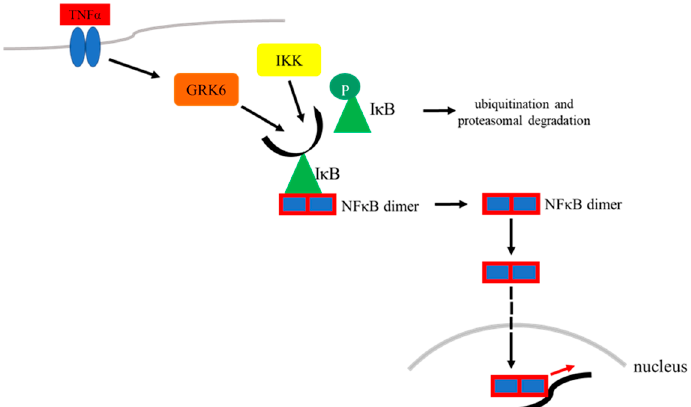
Figure 4. Influence of TNF ‐α induced activation of GRK6 on NF κ B signaling. GRK6 corresponds to the inhibitor of NF κ B kinase (IKK) in its phosphorylating function to the inhibitor of NF κ B (I κ B) [88]. Therefore, both enzymes initiate I κ B’s ubiquitination and proteasomal degradation. The unbound NF κ B dimer subsequently translocates to the nucleus and induces gene transcription.